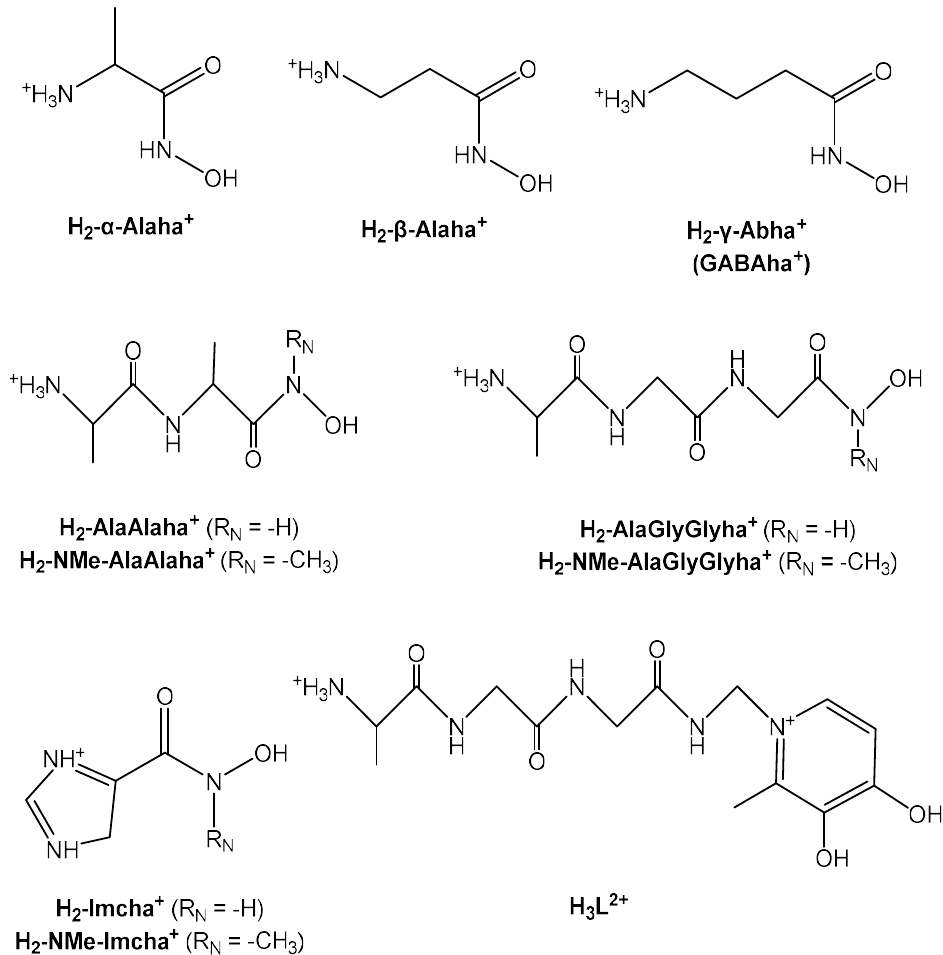
Scheme 2. Structures of the fully protonated form of the ligands discussed.